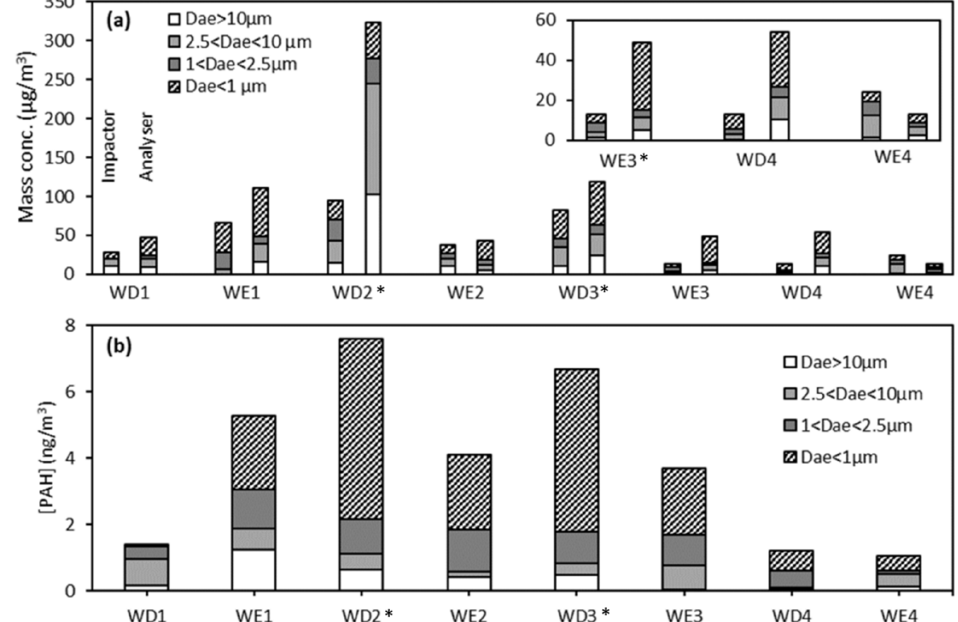
Figure 4. Temporal variation of ( a ) particulate matter on the impactor and analyser (inset = zoom of WE3, WD4 and WE4) and ( b ) total PAHs on the impactor for the different particle size fractions. (* used to indicate the sampling periods when the pollution episodes occurred.)